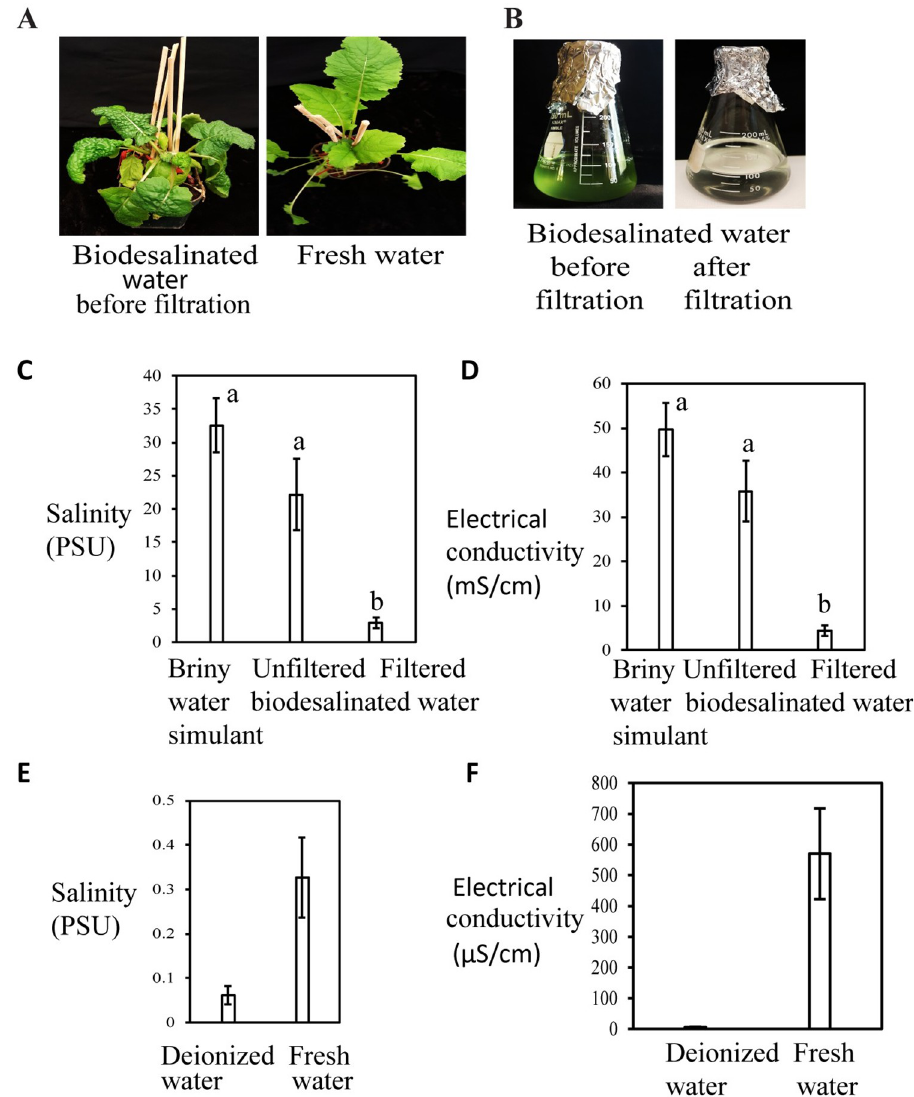
Fig 6. (A) Growth of turnip plants (after 3 weeks) in alfalfa treated basaltic regolith simulant soil watered with unfiltered biodesalinated water or fresh water (control). (B ) Flasks containing biodesalinated water before or after filtration. (C) Salinity and (D) EC of unfiltered and filtered biodesalinated water, and starting briny water simulant material. (E) Salinity and (F) EC of deionized water and fresh water (controls). At least three replicates per water type were used for salinity and EC measurements. Data represent average ± SE. (C and D) Average salinity or EC of samples that do not share a letter above the bar are significantly different (P < 0.0001) as determined by one-way